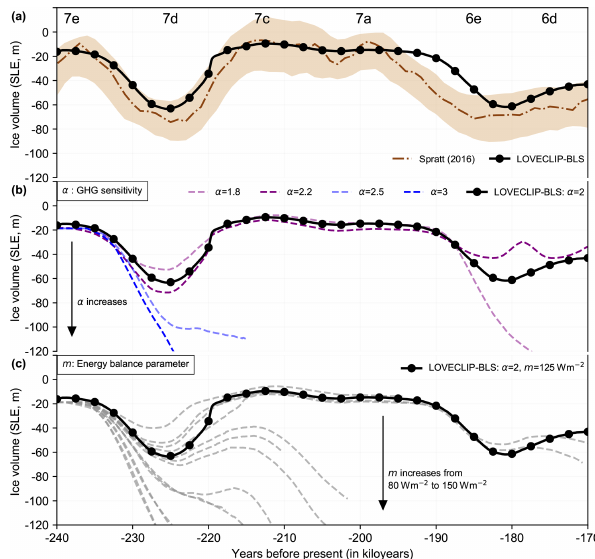
Figure 3. Transient simulation and parameter sensitivity over MIS 7. (a) Sea level reconstruction (m) of Spratt and Lisiecki (2016) (brown) and total ice volume (in terms of SLE, m) from LOVECLIP baseline simulation (BLS; experiment 1 in Table 1 using α = 2 and m = 125Wm − 2 ). (b) LOVECLIP ensemble runs with vary- ing GHG sensitivities ( α , Eq. 1) and a melt parameter value ( m , Eq. 3) of 125Wm − 2 . The best results are obtained for an α of 2. (c) LOVECLIP ensemble runs with α of 2 and different values of the melt parameter ( m ; Wm − 2 ). The best results are obtained for an m of 125Wm − 2